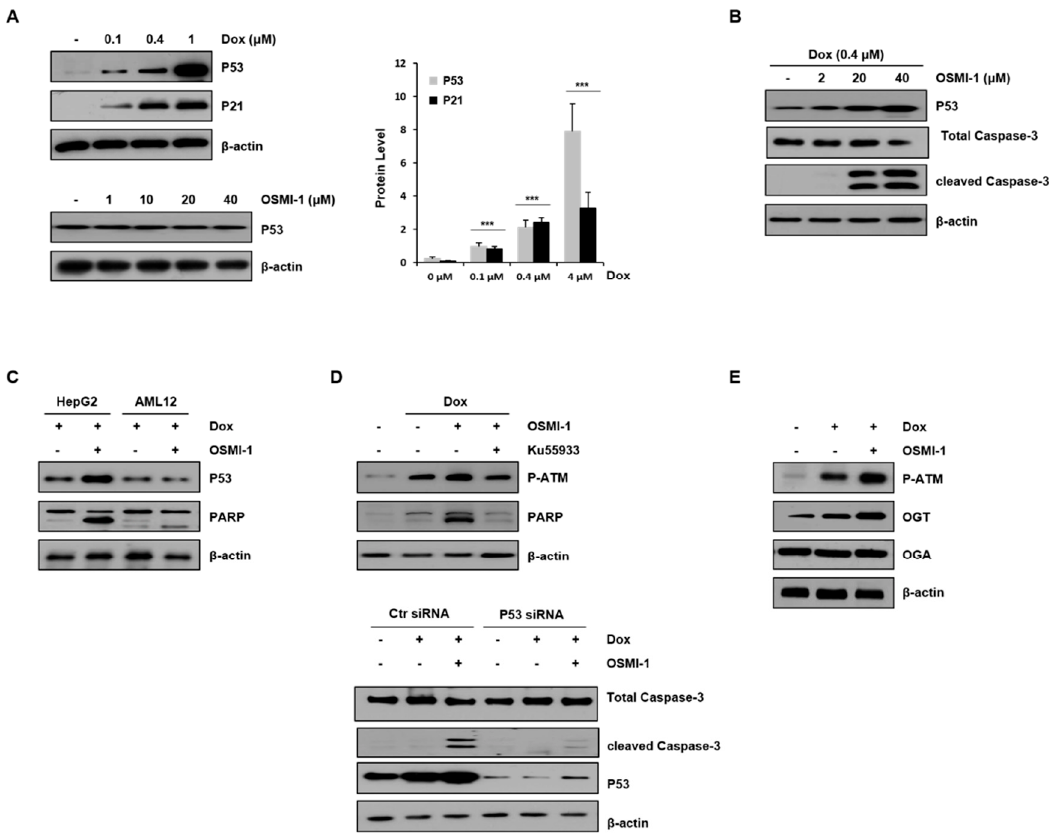
Figure 2. OSMI-1 enhances DOX-induced apoptosis in HepG2 cells via p53 signaling. ( A ) Protein levels of p53 and p21 in HepG2 cells treated with 0, 0.1, 0.4, and 1 μ M of DOX for 15 h were analyzed by Western blot (upper panel). The graphs on the right show the relative amounts of protein as fold increase. *** p < 0.005 compared with the control group. Similarly, p53 levels in HepG2 cells treated with various concentrations of OSMI-1 (1–40 μ M) were analyzed (lower panel). β -actin was used as an internal control. ( B ) DOX (0.4 μ M)-induced HepG2 cells were treated with various concentrations of OSMI-1 (2–40 μ M) for 15 h. Western blot analysis was performed to determine levels of p53 and cleaved caspase-3. ( C ) HepG2 and AML12 cells were treated with DOX (0.4 μ M) alone or in combination with OSMI-1 (20 μ M) for 15 h. Levels of p53 and PARP were detected by Western blot. ( D ) The upper panel shows HepG2 cells pretreated with 0.4 μ M of DOX and treated with 20 μ M of OSMI-1 alone or in combination with 10 μ M of ku55933. Cell lysates were analyzed by Western blot using antibodies against phospho-ATM and cleaved PARP. The lower panel shows HepG2 cells after transfection with control or p53 siRNA, which were then treated with DOX (0.4 μ M) alone or in combination with OSMI-1 (20 μ M) for 15 h. Cell extracts were analyzed for cleaved caspase-3 by Western blot. ( E ) HepG2 cells were treated with DOX (0.4 μ M) alone or in combination with OSMI-1 (20 μ M) for 15 h. Cell lysates were analyzed by Western blot using antibodies against phospho-ATM, OGT, and OGA. β -actin was used as an internal control. Values are presented as mean ± SD of three independent determinations, the uncropped western blot figures in Figure S4.